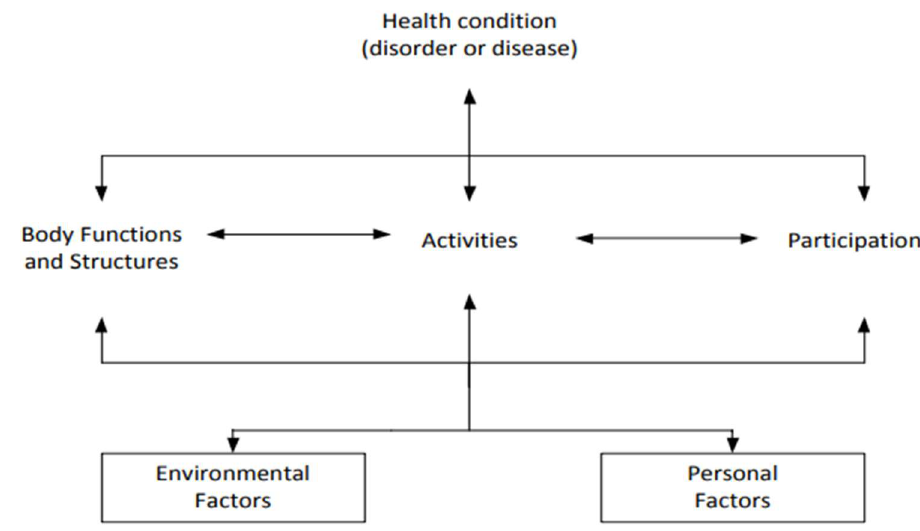
Figure 1. Bio-psycho-social model: This is an open access article distributed under the Creative Commons Attribution License, which permits unrestricted use, distribution, and reproduction in any medium, provided the original work is properly cited [7].